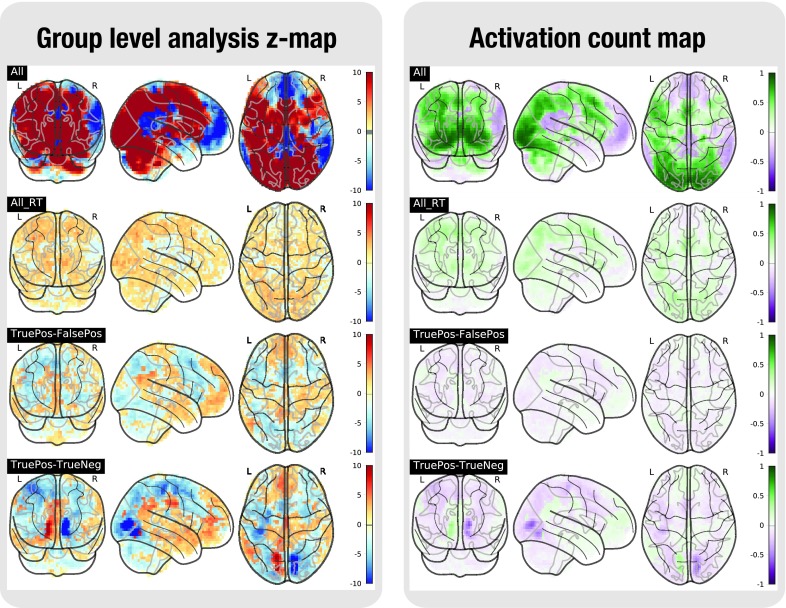
Task analysis results for the PAMRET task.In the left plot, the statistical map of the one-sample group test, computed with randomise. The right plot shows the difference between the positive and the negative activation count maps.